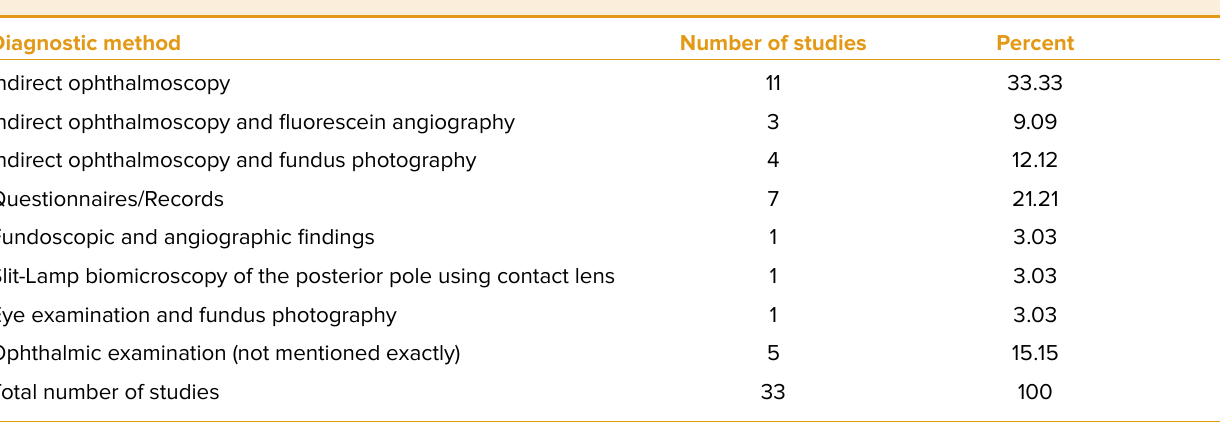
Table 3. Findings about diagnostic methods for diabetic retinopathy Diagnostic